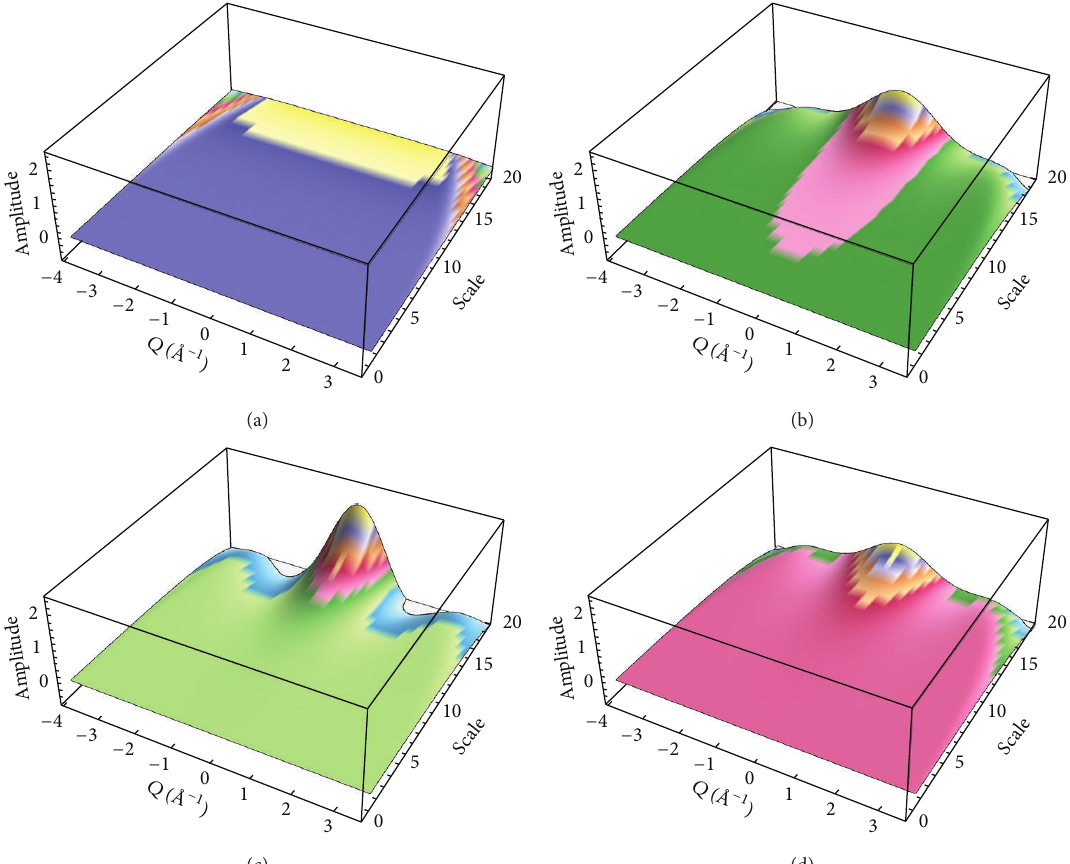
Figure 3: 3D scalograms of a wavelet analysis for sucrose/water mixtures, at three different temperatures, (a) 𝑇 = 19 K, (b) 𝑇 = 264 K, and (c) 𝑇 = 284 K, and (d) 3D scalogram of a wavelet analysis for trehalose/water mixtures at 𝑇 = 264 .